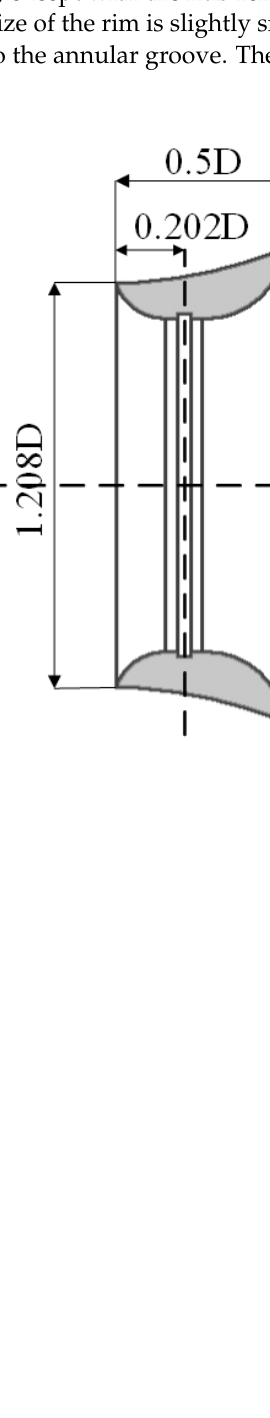
Figure 3. Schematic view of the DT and the